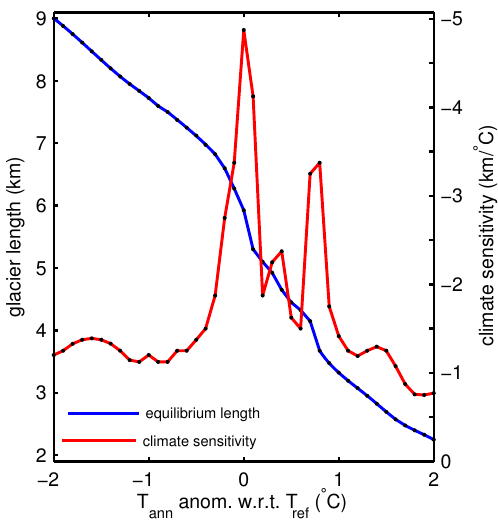
Fig. 9. Equilibrium length (blue, left scale) and climate sensitivity (red, right scale) of Glaciar Fr´ıas as a function of annual tempera- ture anomaly w.r.t. the 1980–2009 mean. Equilibrium lengths (and therefore also climate sensitivities) are calculated for each 0.1 ◦ C step in annual temperature anomaly (black